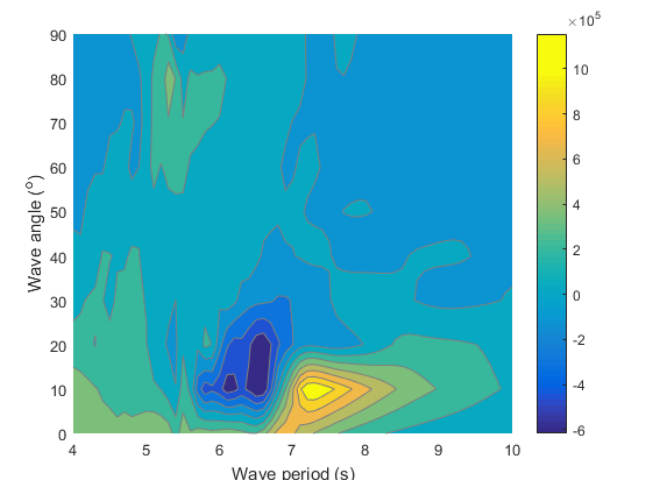
Fig. 12. Power extraction via pitching of duck 1 (upstream end of spine), measured in Watts.